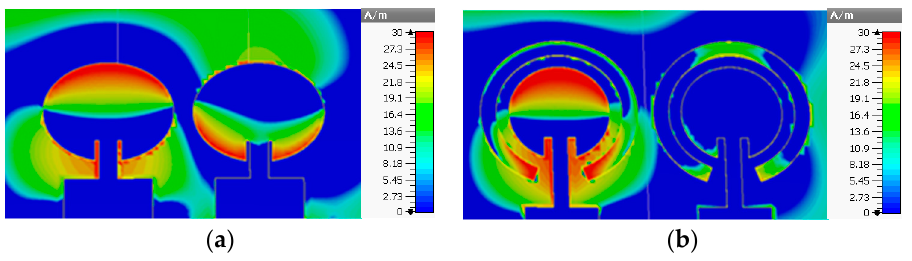
Figure 10. Current distribution for ( a ) Antenna 1 and ( b ) Antenna 2.